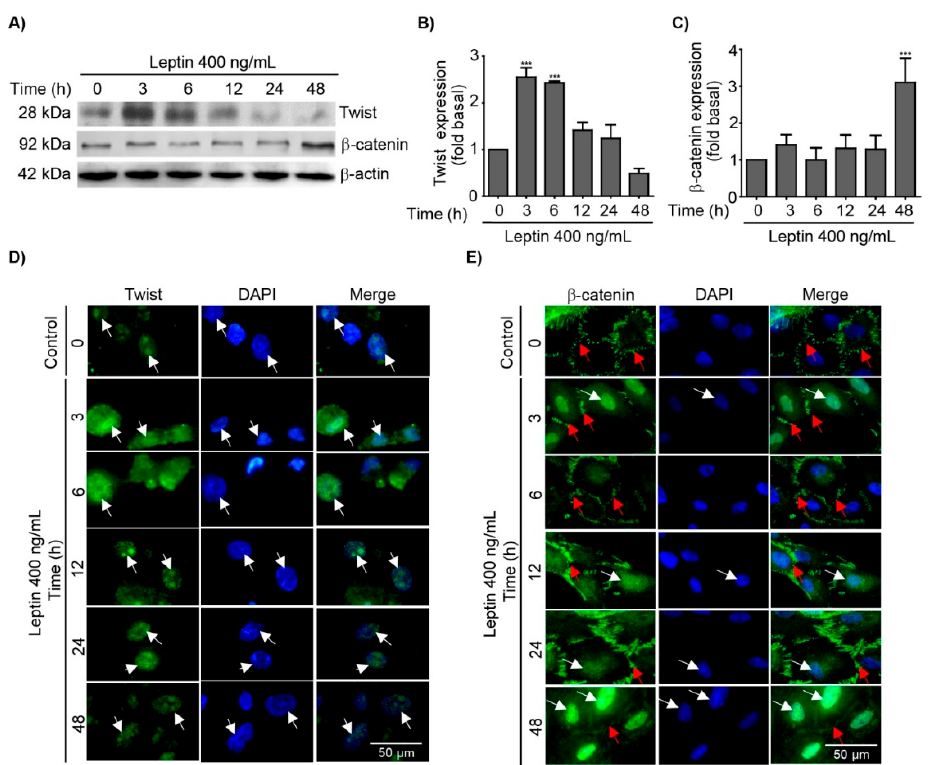
Figure 2. Leptin induces the expression of the epithelial–mesenchymal transition (EMT)-related transcription factors, Twist and β -catenin in MCF10A cells. MCF10A cells were treated with leptin 400 ng/mL for different times and the expression and localization of Twist and β -catenin was analyzed. ( A ) Representative western blot of Twist and β -catenin. β -actin was used as a loading control. Densitometric and statistical analysis of the bands obtained by western blot for Twist ( B ) and β -catenin ( C ); the values are shown in means ± SD of three independent experiments, and are expressed as changes in respect to the control (unstimulated cells). The asterisks indicate the comparison made with respect to the control. *** p < 0.001 by one-way ANOVA (Dunnett´s test). Representative immunofluorescence microscopy images showing in green, the expression of Twist ( D ) and β -catenin ( E ), the nucleus was counterstained with DAPI. White arrows indicate the nucleus; red arrows indicate cell membranes. Images were acquired using the 100× magnification.